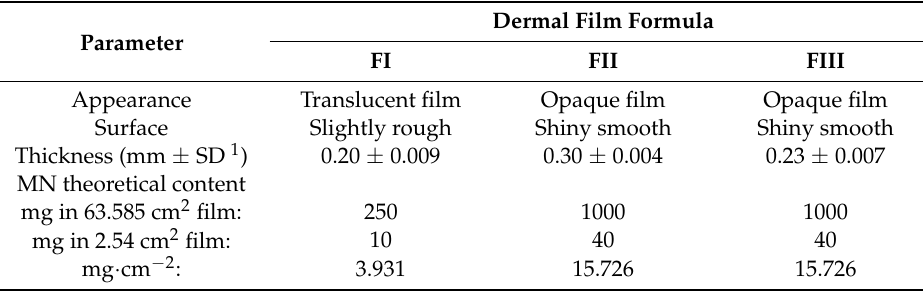
Table 2. Physical characteristics of the obtained miconazole nitrate films.